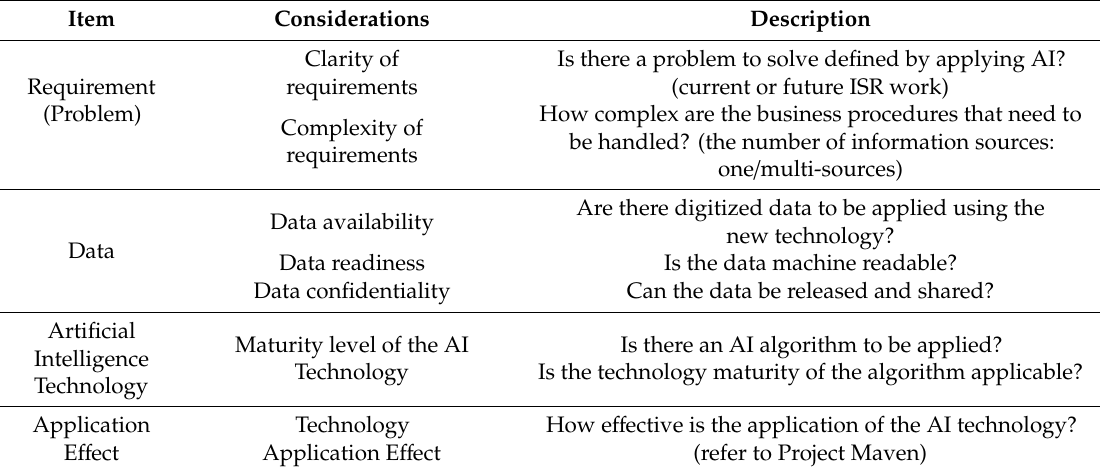
Table 2. Criteria for determining the